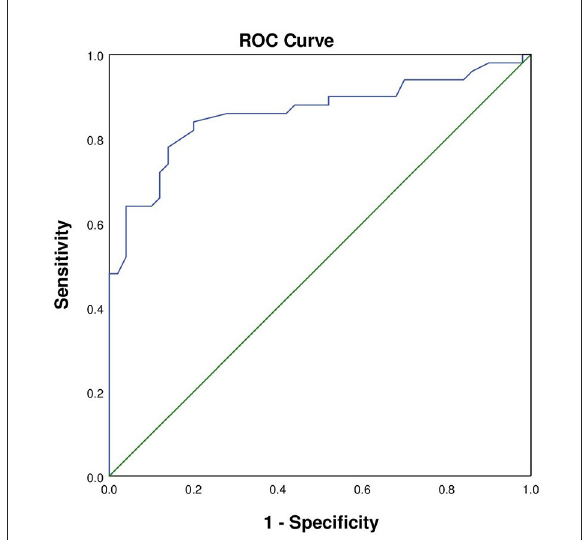
FIGURE2 The ROC curve of AMI patients with in-hospital GIB. The area under the curve was 0.860 (95% CI: 0.78–0.94, P = 0.039). The sensitivity was 0.84 and the specificity was 0.80.